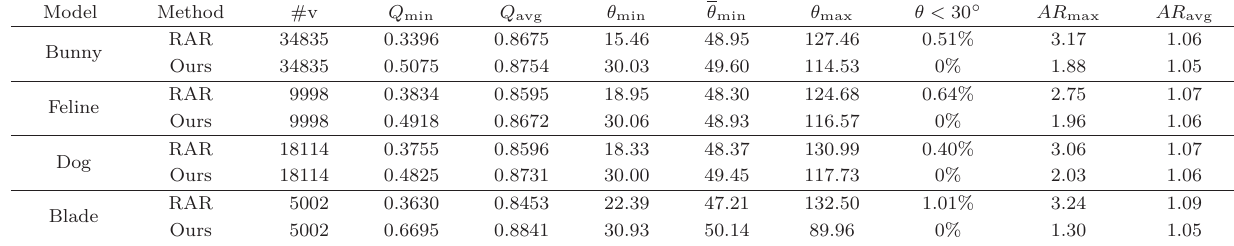
Table 3 Comparative remeshing results, adaptive